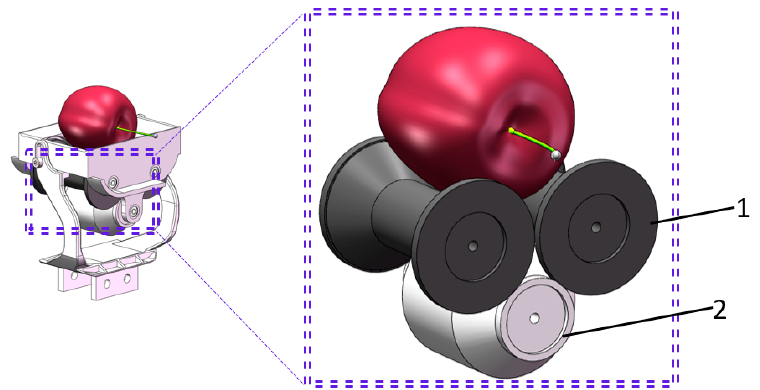
Figure 5. Structure of rotating roller mechanism: 1—double-roller supporter and 2—driven roller.